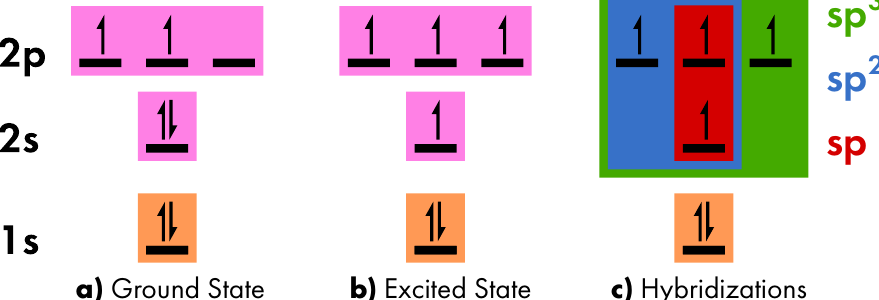
Figure 2. Electronic configuration diagram vs energy for carbon atom in its ( a ) ground state and ( b ) excited state and ( c ) possible hybridization types: sp (red), sp 2 (blue), and sp 3